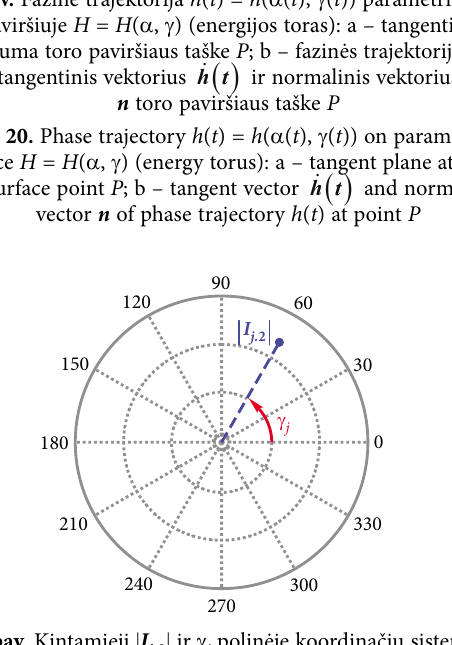
(cid:95) and (cid:74) in the polar coordinate system j .2 j